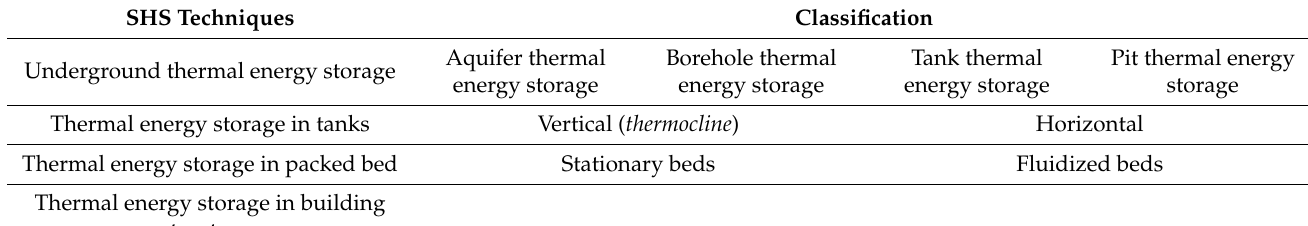
Table 3. SHS techniques and their classification, reprinted/adapted with permission from Ref. [38], 2022,